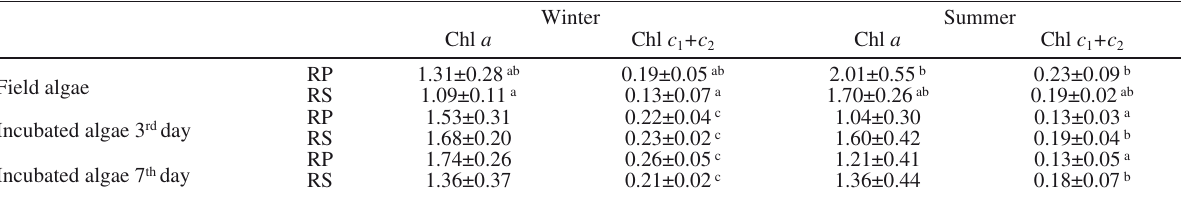
+c expressed as mg g –1 DW in C. tamariscifolia collected in winter (February) and sum- Table 5. – Concentration of internal Chl a and Chl c 1 2 mer (July) from rocky shores (RS) and rockpools (RP) from field material (field algae) and after 3 and 7 d incubation in 1.5-L UV-transparent cylindrical vessels under solar radiation (incubated algae). Data are expressed as mean±standard deviation of n=6 and lower-case letters denote significant differences after SNK test.